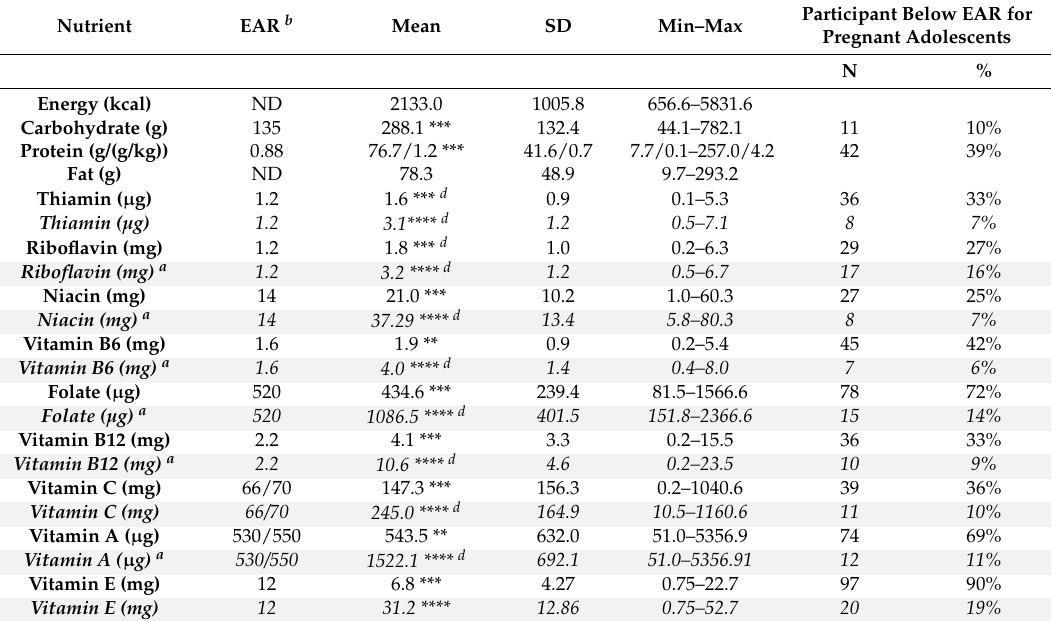
Table 2. Nutritional characteristics of 108 pregnant Latina adolescents measured with a 24-hour food recall during the 2nd trimester of gestation and comparison with the Estimated Average Requirement